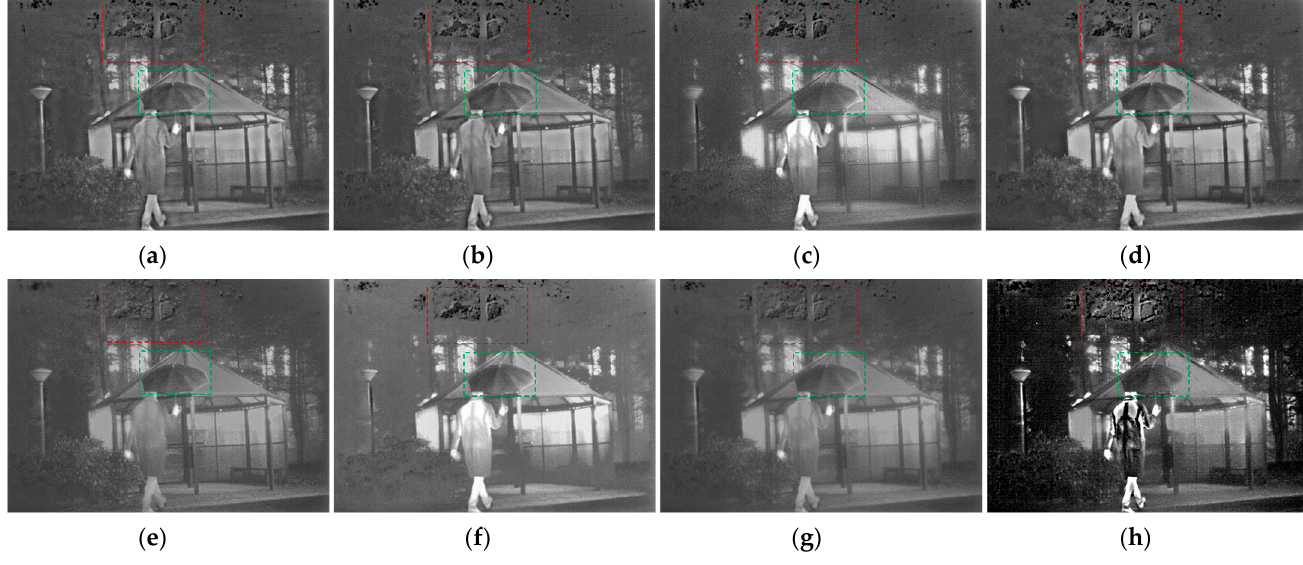
Figure 8. Performance comparison of different fusion methods on the image pair “Umbrella”. ( a – h ) are the results of CVT, CWT, WLS, LP, ADF, GTF, MSVD and our algorithm, respectively.